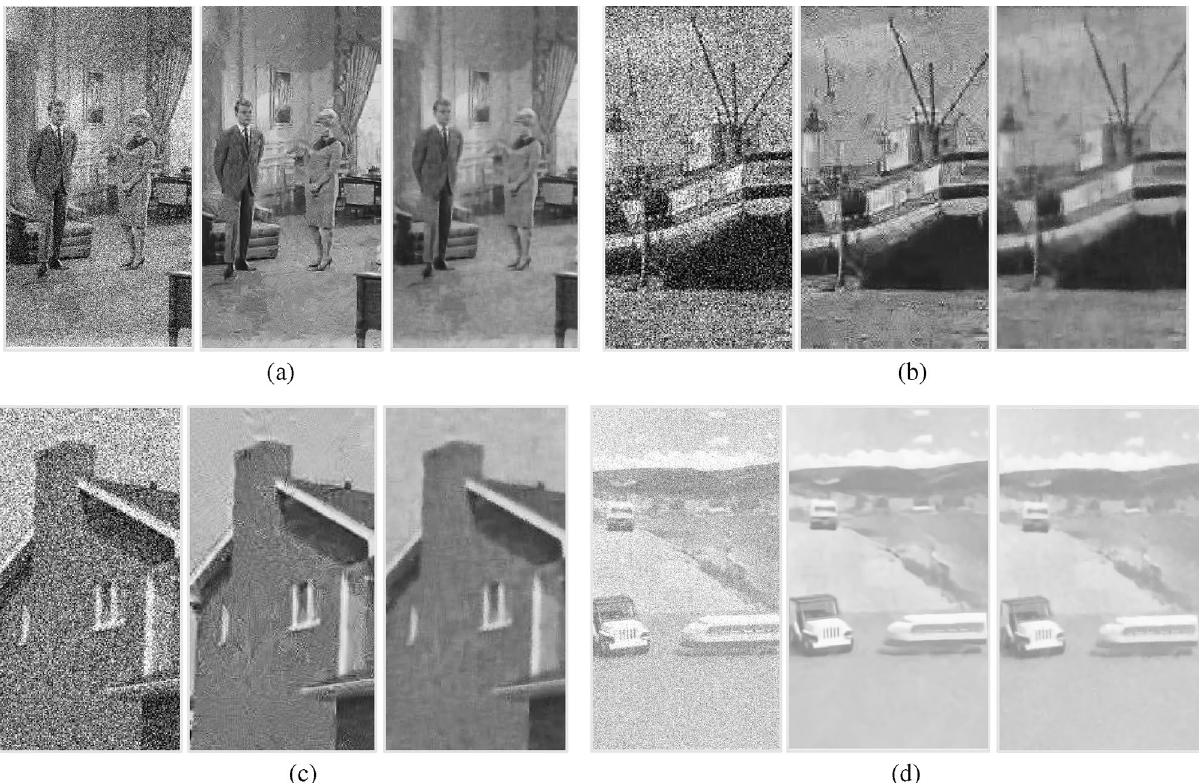
Figure 8. The comparison of denoised images between BM3D and the proposed ( σ 2 = 35 , The left is the noise image, the middle is the BM3D denoised image, and the right is the denoised image of the proposed method) ( a ) couple ( b ) Boat ( c ) House ( d ) Toy